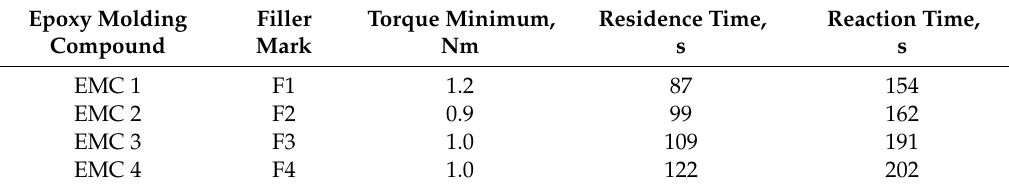
Table 3. Evaluations of torque rheometer plastograms for each EMC granulate.